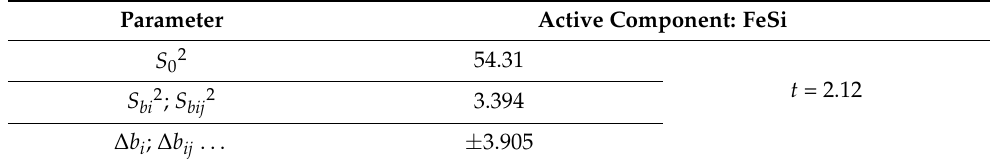
Table 4. Statistical verification of coefficients of regression